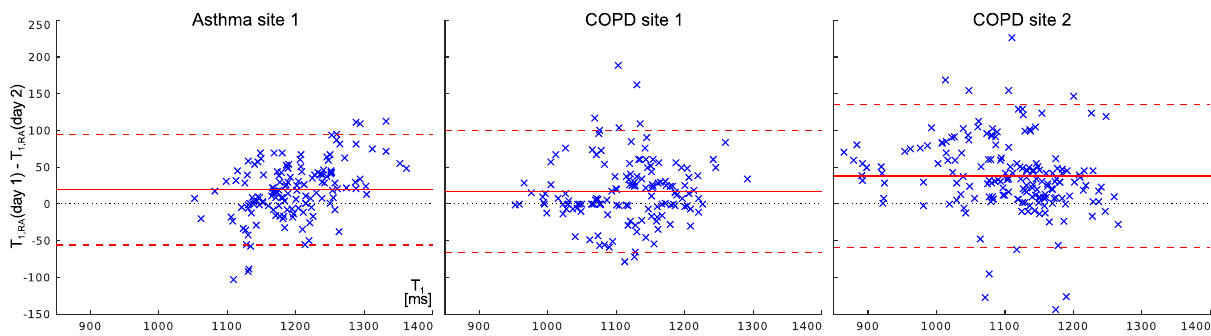
Fig 3. Bland-Altman plots comparing the difference in T 1 under room air conditions measuredat day 1 and day 2 to the averageof both days. Data from asthma and COPD patients examinedat both sites is shown. The averagedifference is shown as a solid line and 95% confidenceintervals (1.96 σ )as dashed lines.